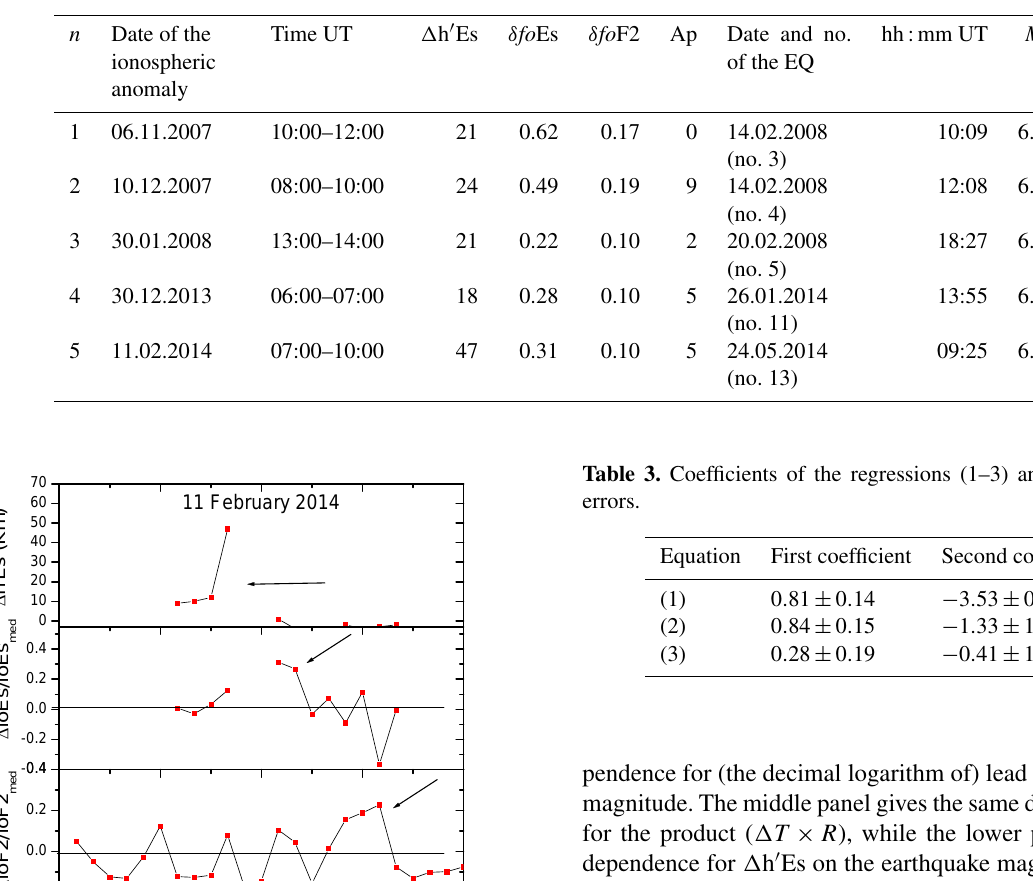
Table 2. Identified ionospheric anomalies and corresponding EQs (the EQ order no. is the same used in Table 1). Daily Ap indices are given as well.